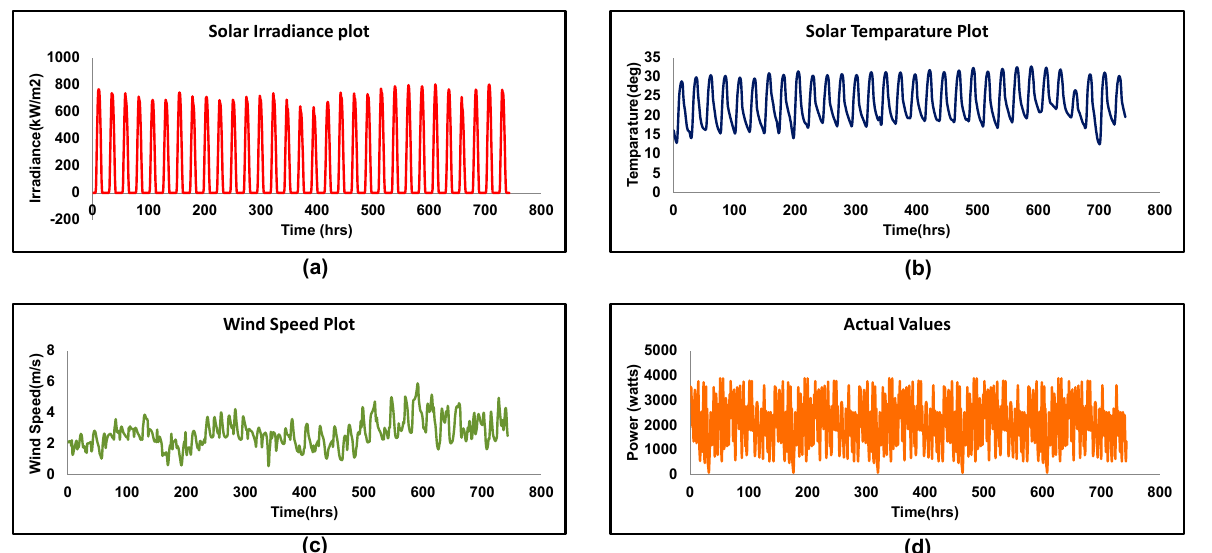
Figure 7. Characteristics of data considered in the specified location: ( a ) solar irradiance, ( b ) solar temperature, ( c ) wind speed, and ( d ) actual values of power.